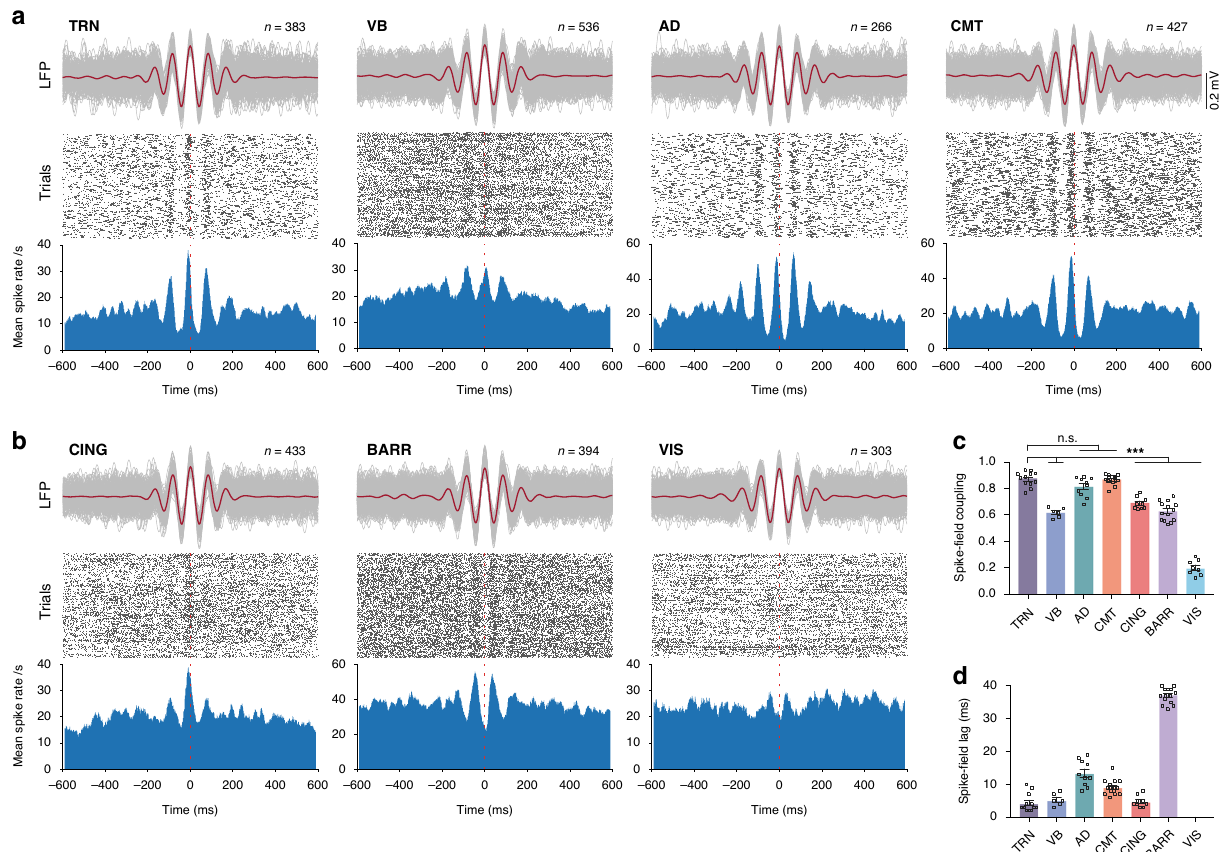
Fig. 2 Cellular substrates of regional sleep spindles in thalamic nuclei and cortical sites. a Representative average (red) and individual (gray) traces of thalamic spindles fi ltered within the spindle range (9 – 16 Hz) and aligned to peaks of central cycles of spindles. Each gray line represents one spindle, and n indicate the number of spindles. Raster plots show single-unit activity of thalamic neurons during spindles, where each trial represents one spindle. The average neuronal fi ring rate of trials were obtained using a moving window of 10 ms having 80% overlap. Zero time indicates peaks of central cycles of spindles. b Same as a , but for cortical LFP/unit recordings. c Quanti fi cation of spike – fi eld coupling during spindles using the normalized cross-correlation between fi ltered LFPs and average spike rate traces. Spike – fi eld coupling within CMT and AD nuclei is as strong as in TRN (TRN vs. CMT: P > 0.99; TRN vs. AD: P = 0.18; F = 162.6; d.f. = 6; one-way ANOVA with Tukey ’ s post-hoc test; *** P < 0.001; TRN: n = 12, VB: n = 7, AD: n = 10, CMT: n = 15, CING: n = 9, BARR: n = 14, VIS: n = 8 cells; 6 animals for TRN/VB and 12 for other sites). d Time lags between LFPs and single-unit activities of panel c . Error bars indicate mean ± SEM. Source data are provided as a Source Data fi